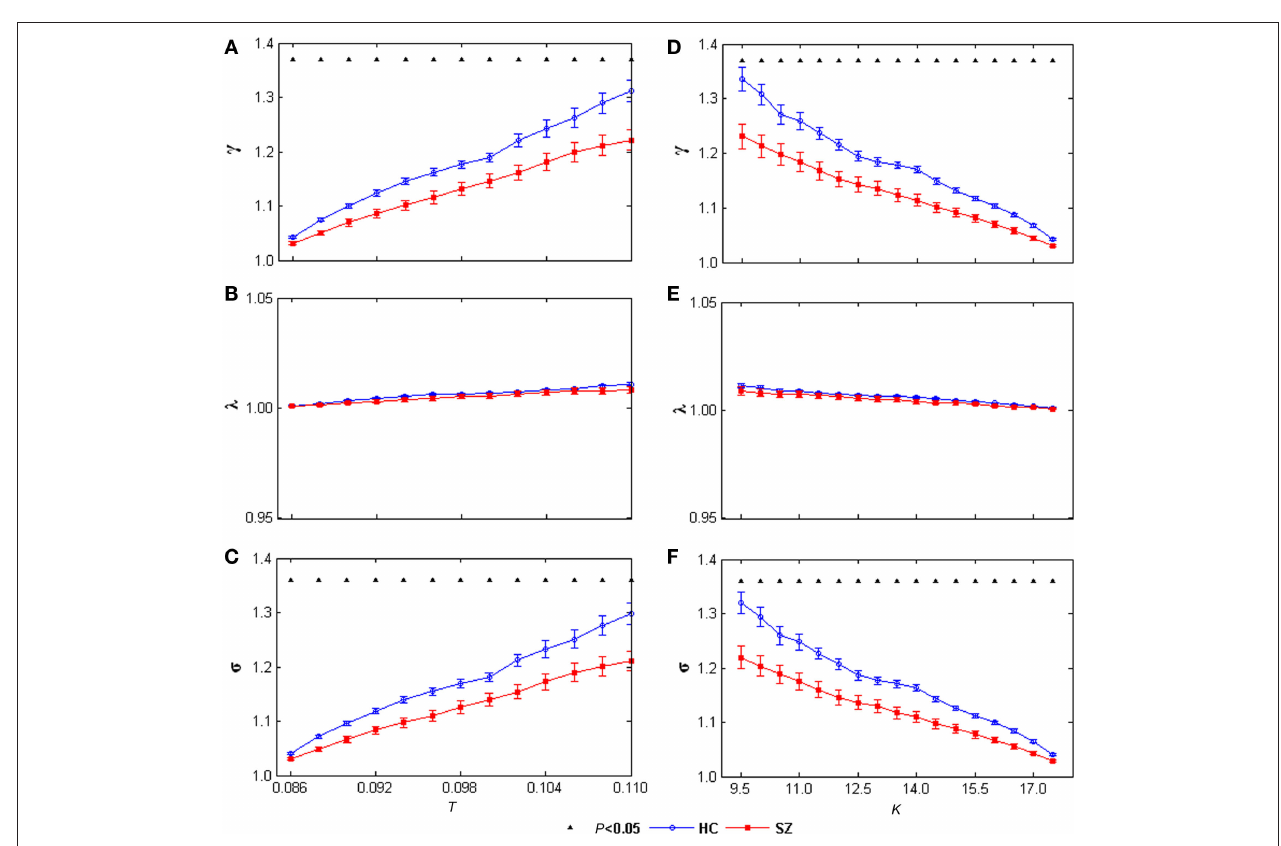
Figure 5 | γ (A) , λ (B) , and σ (C) of the left task-related networks for HCs (blue circles) and SZ (red squares) as a function of thereshold T . γ (D) , λ (e) , and σ (F) of the left task-related networks for HCs (blue circles) and SZ (red squares) as a function of degree K . Error bars correspond to SEM (across 20 subjects of each group), Black triangles indicate where the group difference is significant ( t -test, df = 38, P < 0.05, FDR correction for multiple